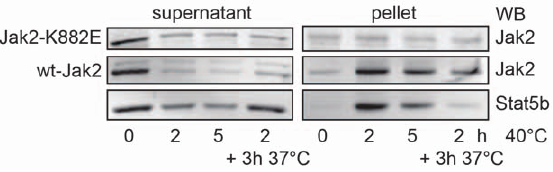
Figure 4. Kinase inactive Jak2 is degraded but not aggregated. c 2A Jak2 2 / 2 were transiently transfected with Jak2-K882E or wild type Jak2, respectively. Equal amounts of cells were incubated at 37 and 40 u C, respectively, for the indicated times. The cells were lysed, fractionated and analyzed as in Fig. 3B. The data in this figure are representative of three independent experiments.